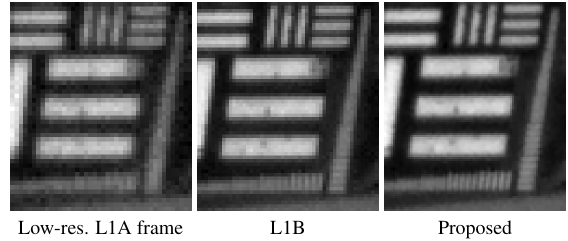
Figure 10. Examples of reconstruction on real resolution test patterns from 35 low-resolution SkySat L1A frames. From left to right: Reference L1A frame, Planet L1B reconstruction ( × 1 . 25 ), proposed method ( × 2 ). ground resolution of 63 cm/pixel ( 0 . 79 cycles/m) for the L1B product and 53 cm/pixel ( 0 . 94 cycles/m) for ACT-spline. This shows that our method produces images with a better quality than the L1B images provided by Planet. Moreover, the pro- posed method produces a × 2 super-resolution image from 35 images ( 2560 × 1080 ) in less than a minute, including 30 s for the registration (CPU), 13 s for the fusion (GPU) and 5 s for the sharpening (CPU). As the registration is also GPU-friendly, it would be possible to significantly speed-up the